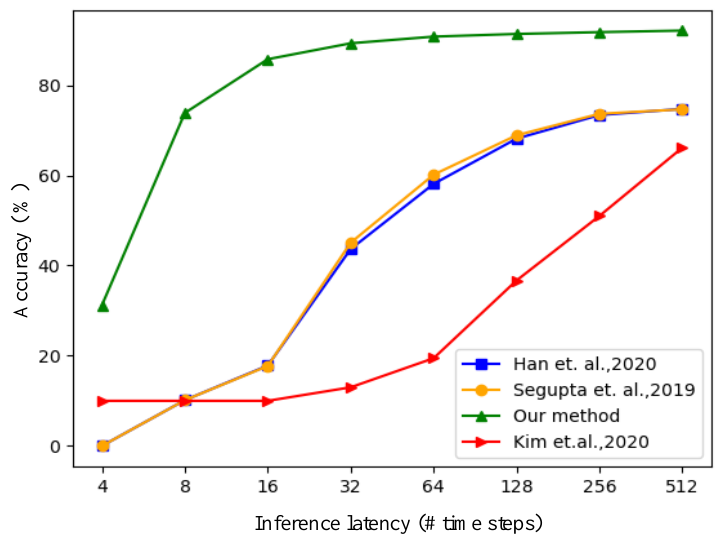
Figure 8. Performance comparison of the proposed method and other CNN–SNN conversion methods on the Fashion-MNIST dataset [25–27].